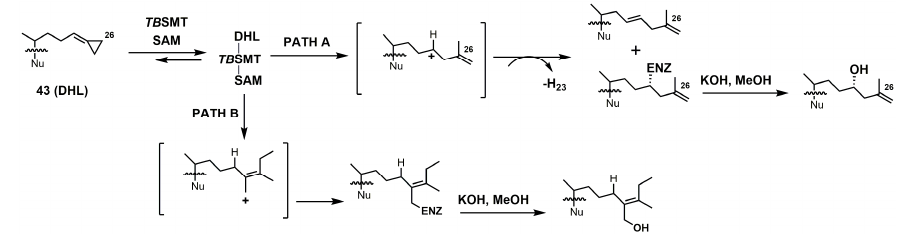
Figure 20. Proposed inhibitory mechanism of Tb SMT with 26,27-dehydrolanosterol (DHL) (adapted from Miller et al., 2017). Nu: lanosterol nucleus.